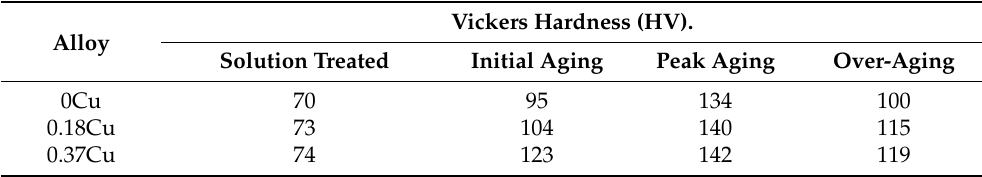
Table 3. Vickers hardness of alloys at different aging stages. Vickers Hardness (HV). Alloy Solution